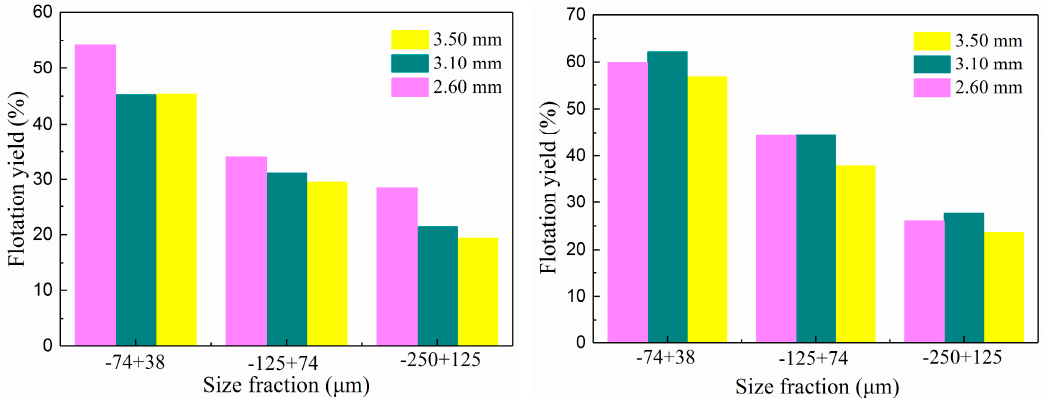
Figure 13. Flotation recovery of different bubble and glass microsphere sizes in 50 mg/L MIBC and 40 mg/L DDA solution; left: The pump speed was 400 mL/h ， right: The pump speed was 1000 mL/h .